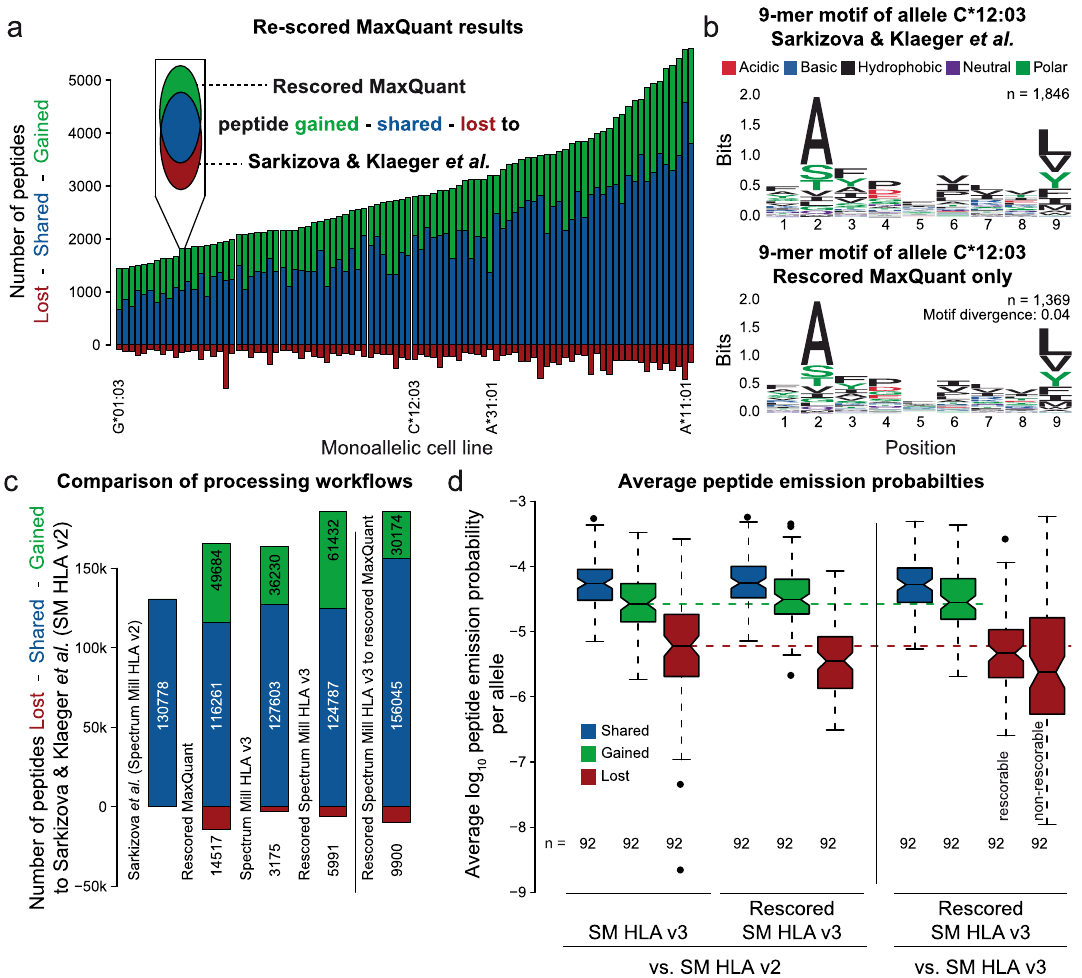
Fig. 3 Deep learning-assisted rescoring of data from 92 monoallelic cell lines. a Vennbars (simpli fi cation of Venn diagram as depicted in the inset) showing the number of peptides lost (red), shared (blue) and gained (green) from Prosit-based rescoring of MaxQuant results of data published by Sarkizova and Klaeger et al. 16 (using Spectrum Mill HLA v2) for each of the 92 monoallelic cell lines investigated in this study. b Peptide motif plot of 1846 9-mers con fi dently identi fi ed to be present in the cell line expressing allele C*12:03 from the published results (top panel) and 1369 9-mers added by the Prosit-based rescoring of MaxQuant results (bottom). Amino acids are colored according to their physio-chemical properties (black denotes hydrophpbic, red acidic, blue basic, purple neutral, and green polar amino acids). The difference between the motifs was estimated by Jensen-Shannon divergence (indicated in the bottom motif) comparing the positional weight matrices of both motifs. c Vennbars showing the number of peptides lost (red bar), shared (blue), and gained (green) when comparing results obtained from different work fl ows to results published by Sarkizova and Klaeger et al. 16 (left of solid vertical line). The bar to the right of the vertical line compares the number of lost, shared, and gained peptides when comparing the Prosit-based rescored results of Spectrum Mill HLA v3 to the Prosit-based rescored results of MaxQuant. d Boxplots of the average emission probabilities (probability that a peptide is derived from a certain motif, see “ Methods ” ) per allele of peptides shared (blue), gained (green) and lost (red) when comparing results obtained from the work fl ows indicated at the bottom of the plot. The number of alleles (n) for which an average emission probability was calculated is depicted at the bottom. Peptides lost (not con fi dently identi fi ed) by the rescored SM HLA v3 work fl ow in comparison to the SM HLA v3 work fl ow are shown separately depending on whether the fragment intensities of the peptide could be predicted by Prosit (rescorable) or not (non-rescorable). The box indicates the interquartile range (IQR). The black line marks the median, notches extend to 1.58 * IQR/sqrt(n), whiskers to 1.5 * IQR from the hinge. Data outside whiskers are plotted individually as black dots. Raw and analysis data are available from the PRIDE repository with identi fi er PXD021398 and MassIVE repository with identi fi ers MSV000084172 and lines 16 using MaxQuant and re-scored all proposed peptide prolines and C-terminal leucine) exhibited the largest increase by spectrum matches (PSMs) by integrating Prosit ’ s fragment a factor of 2 whereas the allele A * 11:01 (C-terminal lysine and intensity predictions ( “ Methods ” ; Supplementary Data 3). Com- arginine) showed the least increase, further corroborating that paring the results to those obtained by Spectrum Mill (SM) HLA Prosit ’ s prediction accuracy is well suited for the analysis of both v2 (Fig. 3a), a search engine that is optimized for the identi fi ca- tryptic and non-tryptic peptides. The observed improvement tion of HLA peptides and that was used in the aforementioned could be solely attributed to rescoring MaxQuant results by study, showed an average improvement by a factor of 1.5 (green integrating intensity information of the fragment ions, as stan- bars) across all alleles and only marginal losses (red bars). The dalone MaxQuant showed substantially fewer peptide identi fi ca- alleles A * 31:01 (C-terminal arginine) and G * 01:03 (internal tions (Supplementary Fig. S12a – e).